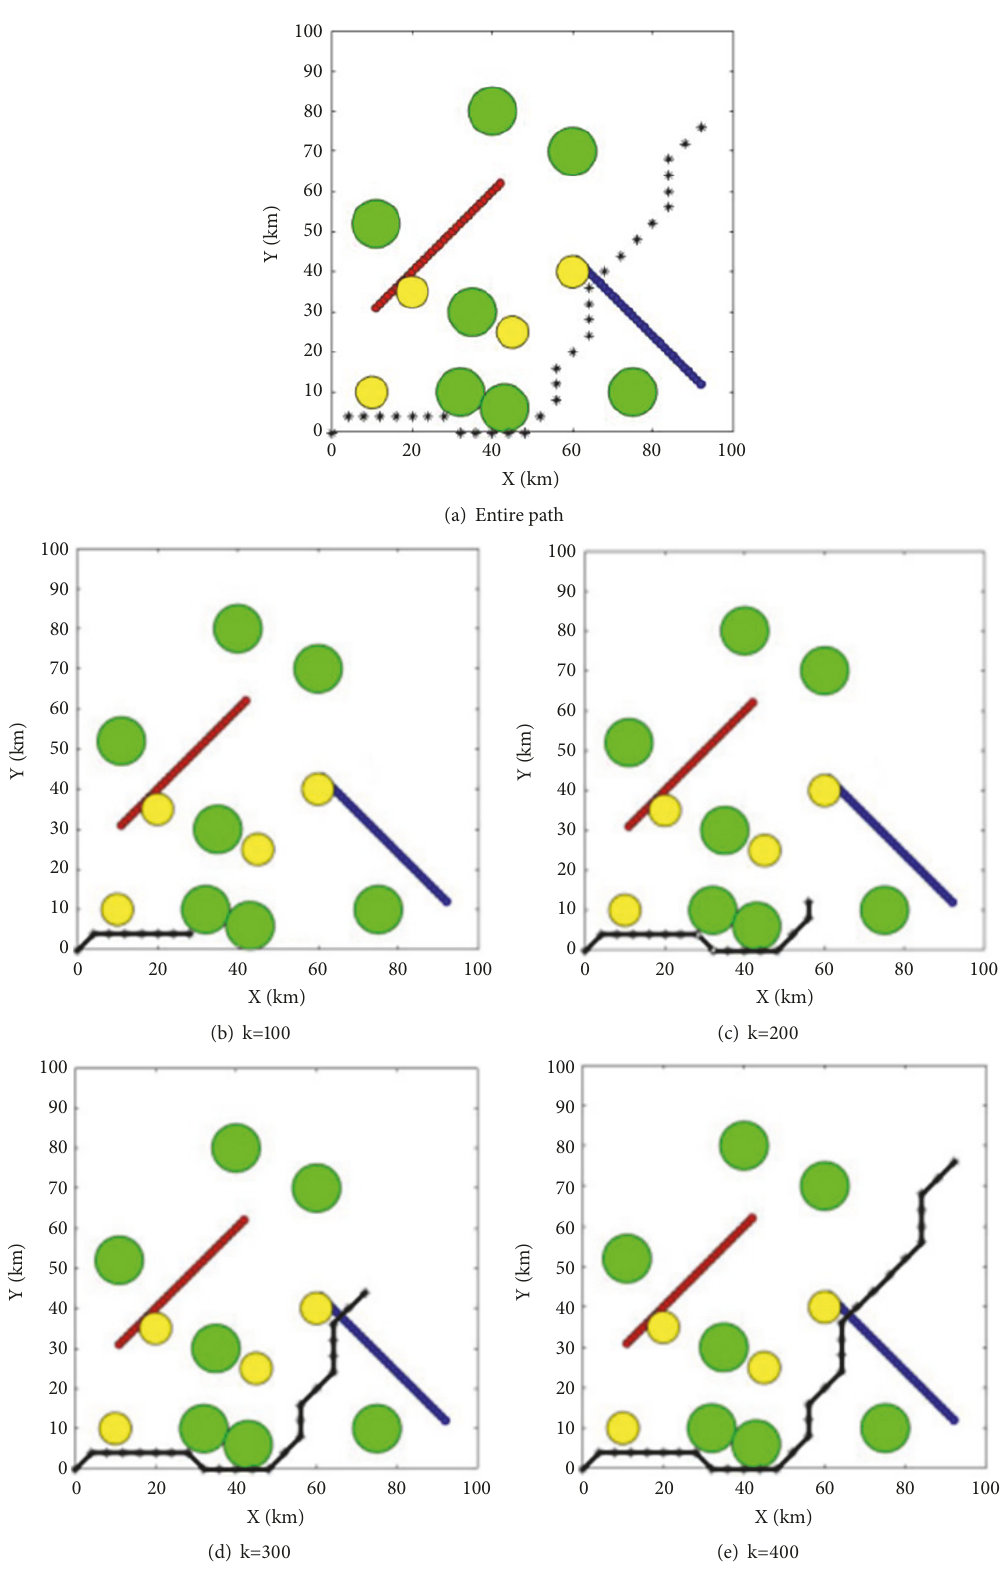
Figure 12: UAV path planning in another environment based on our proposed algorithm. And there are both static and mobile threats where (a) is an entire path and (b) to (e) are paths with iterations = 100, 200, 300,